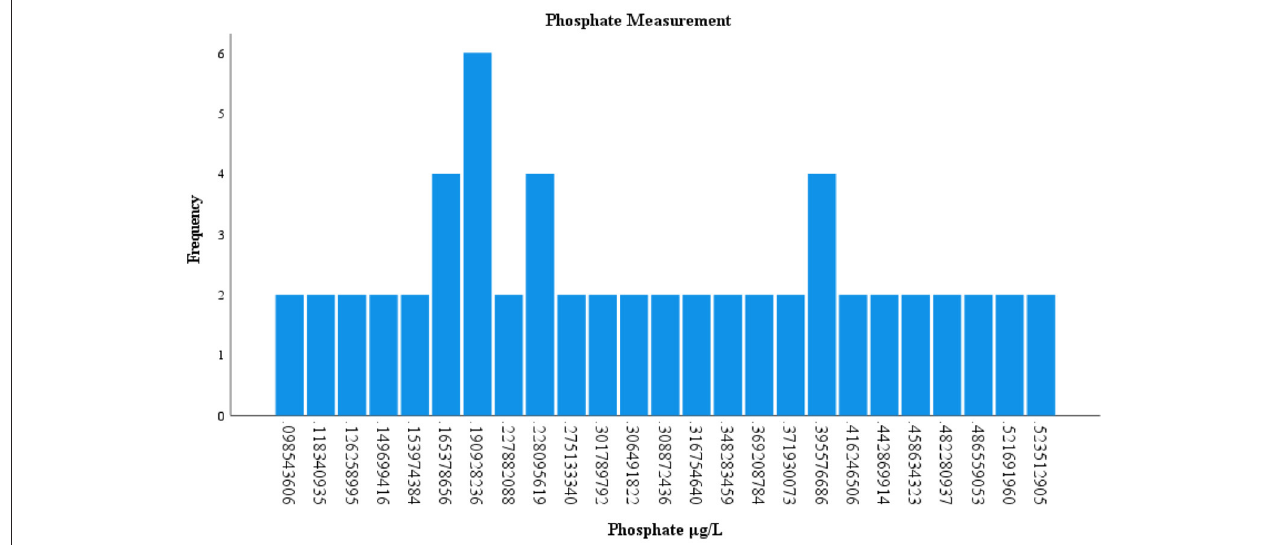
FIGURE 6 | Measurement of phosphate in Lake Manatee and Lake Washington.